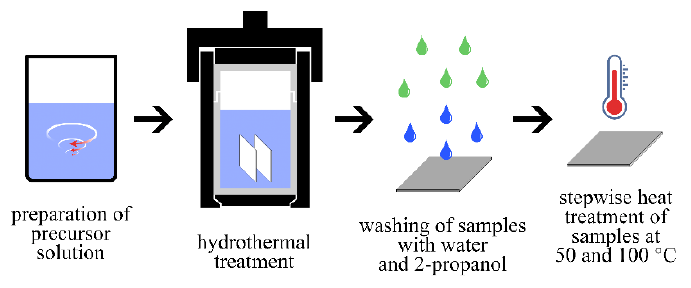
Figure 1. Scheme of the